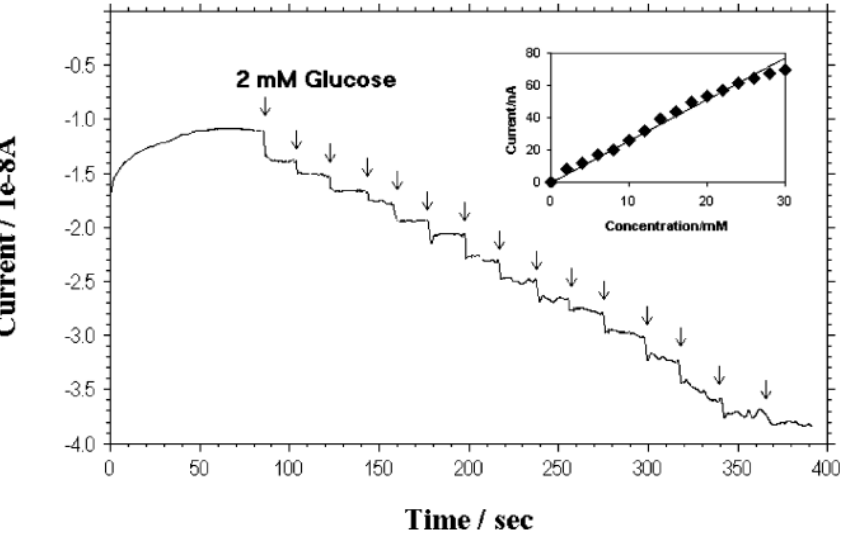
Figure 3. Amperometric responses of a NEE biosensor to successive additions of 2 mM glucose. Reprinted with permission from